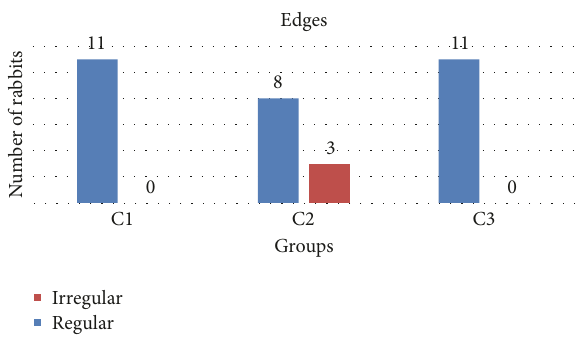
Figure 3: Histological view showed the presence of congestion (neutrophils and monocytes), edema (spaced fibers and cells), and leukocyte diapedesis of PMN after 6 h (x40, H&E staining). incisions, carbonization, and necrotic zones. Graphs (error bars representing each variable’s mean and its 95% confidence interval) were drawn to show differences between groups.